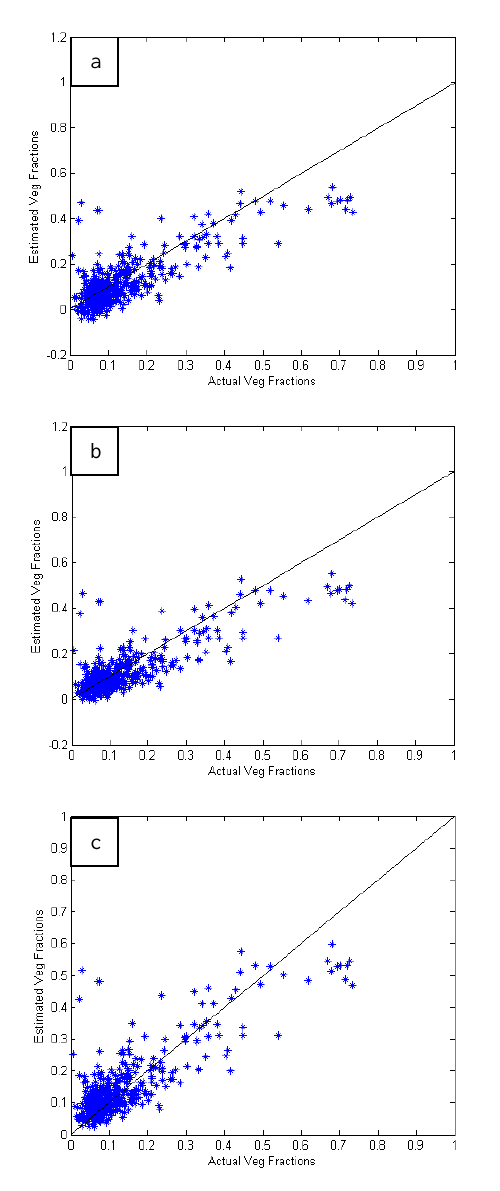
Figure 4. Relationship between actual and estimated fractional vegetation cover ( FVC): (a) linear regression; (b) second-order polynomial regression; (c) neural network The results show that neural network and second-order polynomial regression results are close together. But the results of this two methods is better than linear